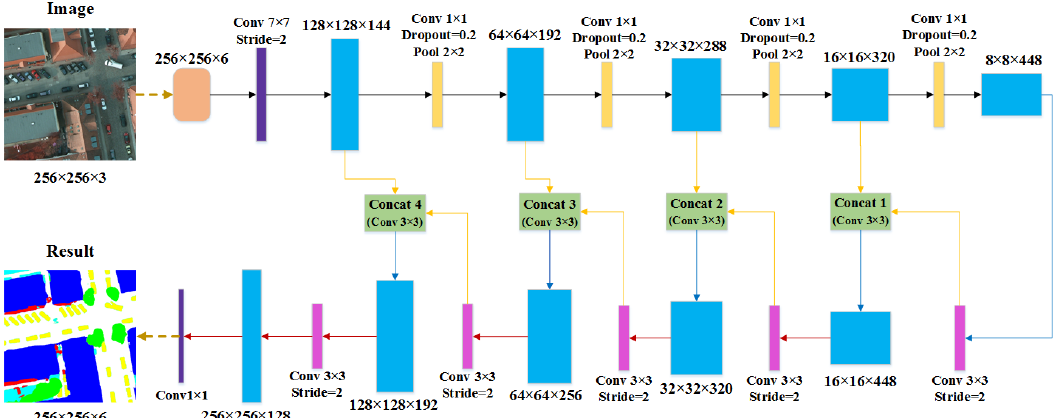
Figure 4. The implementation details of the dense-coordconv network.